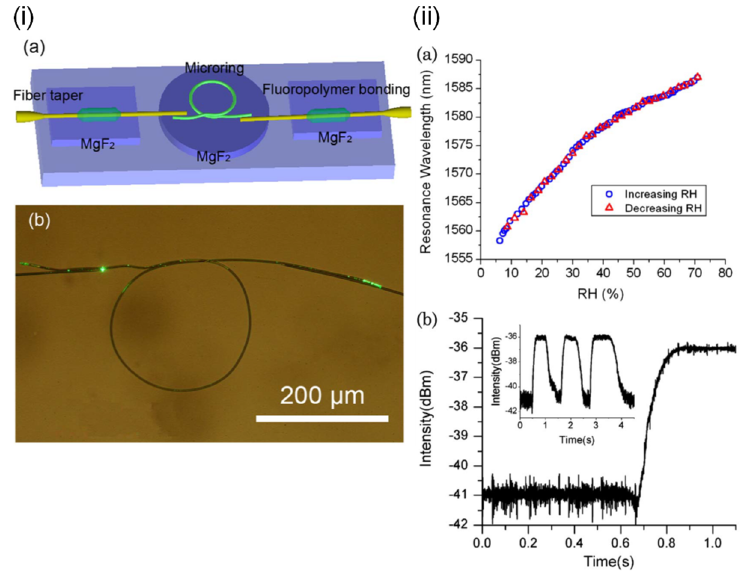
Figure 15. Point sensor. ( i ) ( a ) Conceptual design of sensor head. ( b ) Microscope image of the microfiber ring. ( ii ) ( a ) Resonant wavelength as a function of RH. ( b ) Temporal response. Reprinted with permission from ref. [62]. Copyright 2011 SPIE